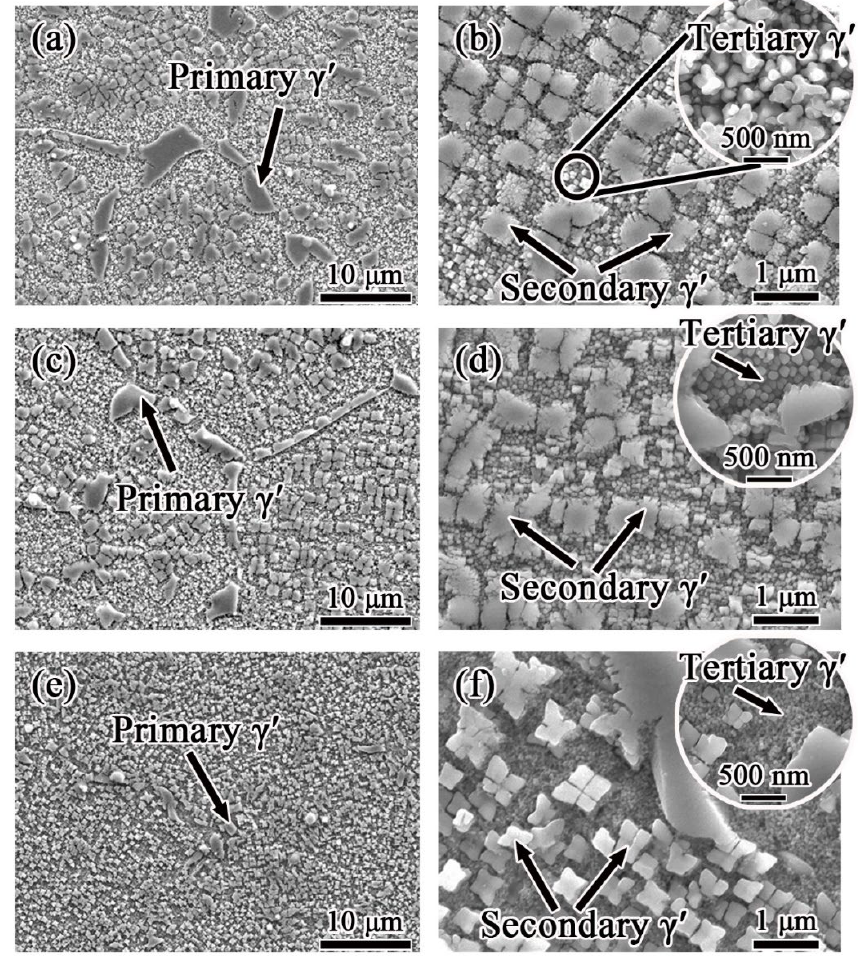
Figure 5. γ (cid:48) morphologies of FGH4107 solutioned at different temperatures: ( a , b ) 1160 ◦ C; Figure 5. γ′ morphologies of FGH4107 solutioned at different temperatures: ( a , b ) 1160 °C; ( c , d ) 1180 °C; ( e , f ) 1200 °C. ( c , d ) 1180 ◦ C; ( e , f ) 1200 ◦